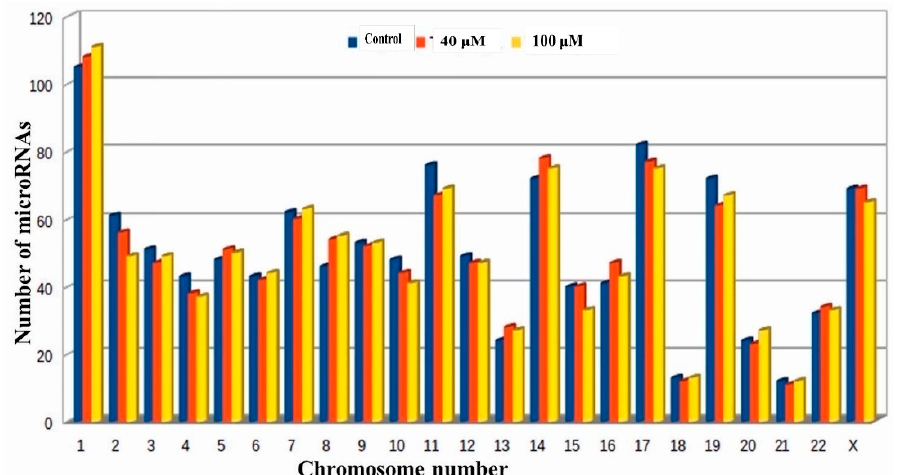
Figure 2. Chromosomal distribution of known microRNAs in the untreated control, 40 and 100 µ M EGCG treatments. Color key- blue: untreated control A549 cells, red: 40 µ M EGCG treatment and yellow: 100 µ M EGCG treatment.